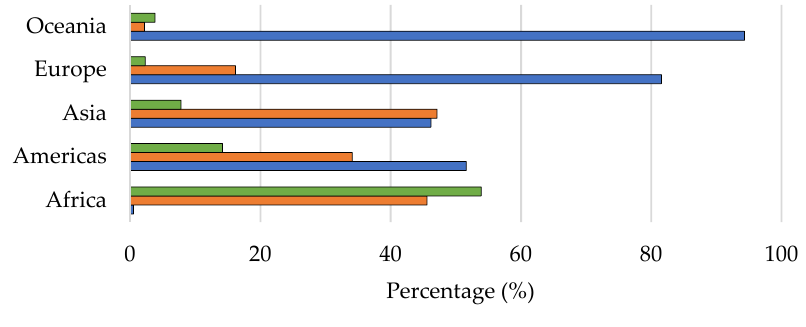
Figure 1. Seafood production of brackish, fresh and marine aquaculture: percentage of total production in 2018 by aquatic system in each continent. Data sources: FAO, 2020; FAOSTAT, 2022.